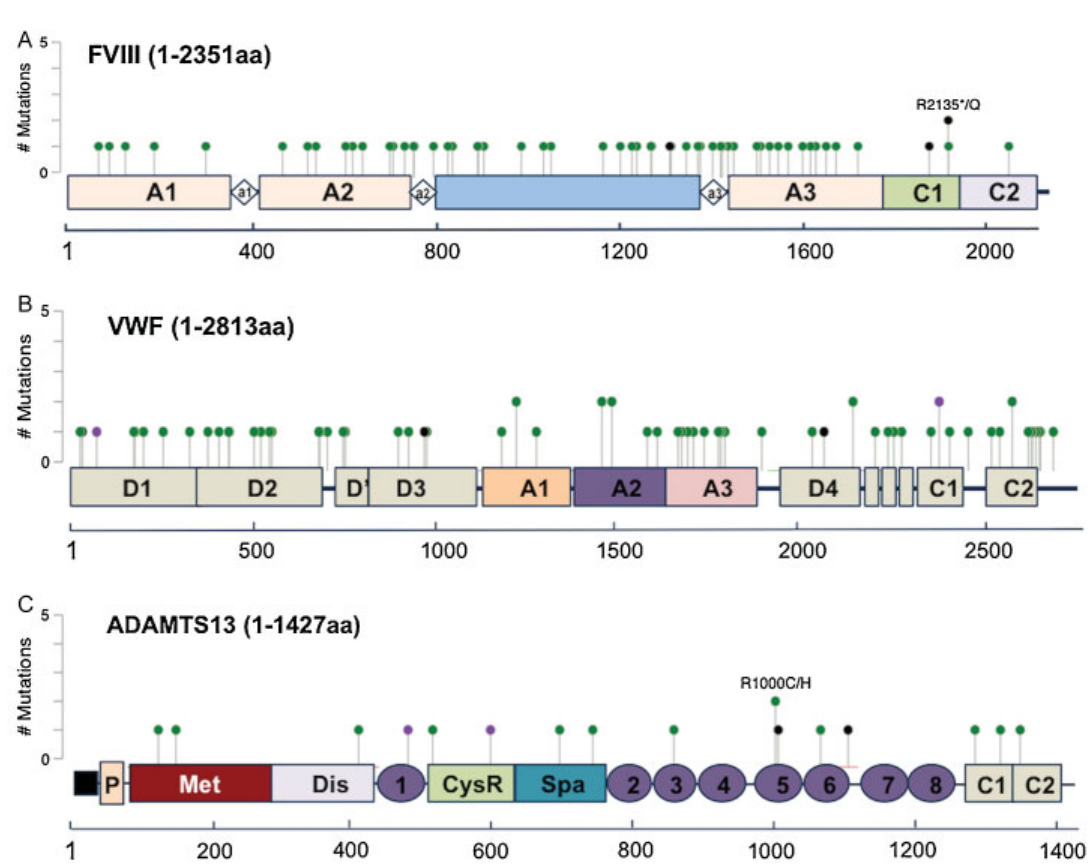
Fig. 3 Detailed mutation maps of FVIII , VWF , and ADAMTS13 found in patients with cutaneous melanoma. Each dot above the protein molecule represents a mutation, which spreads across the entire encoded protein of FVIII ( A ), VWF ( B ), and ADAMTS13 ( C ). There is no evidence of a “ hotspot ” of gene mutations.